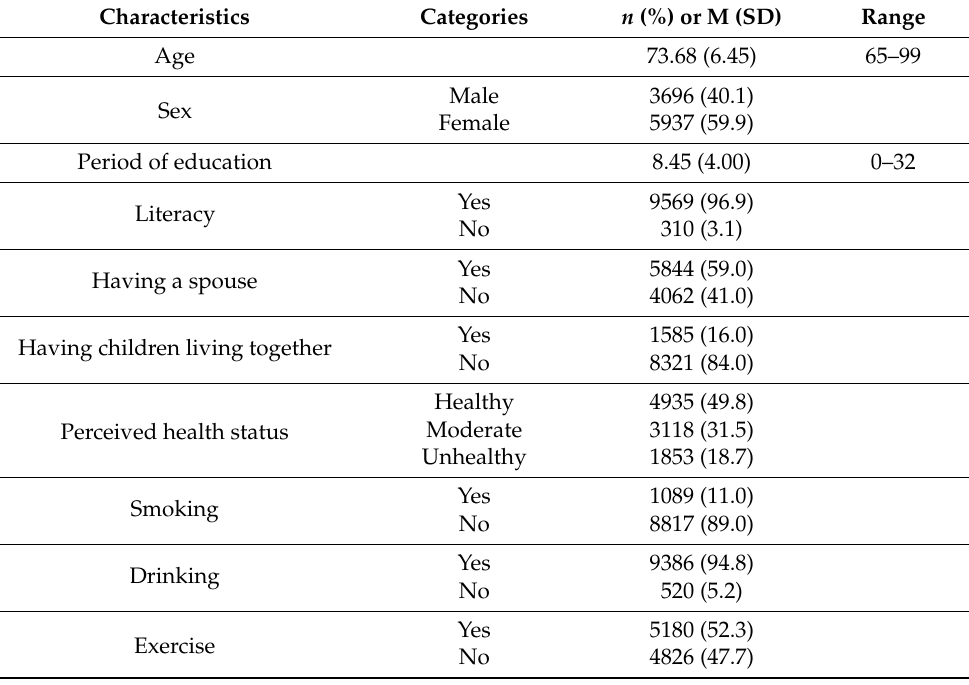
Table 1. General characteristics ( n = 9906).